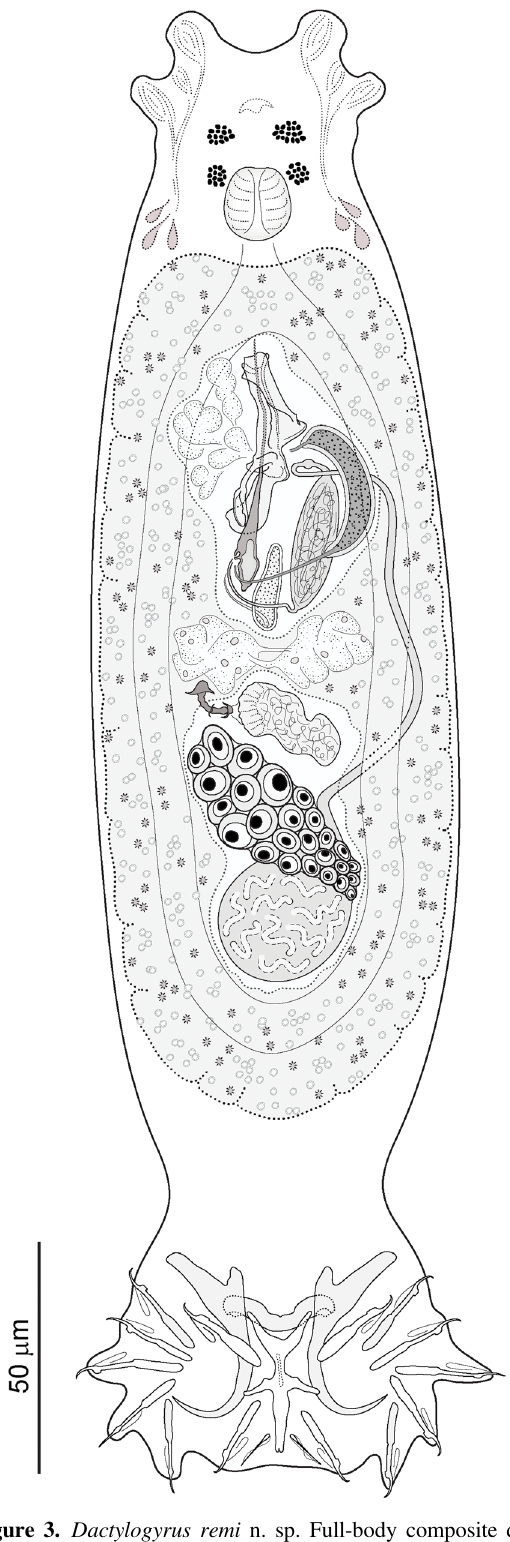
Figure 3. Dactylogyrus remi n. sp. Full-body composite drawing, ventral